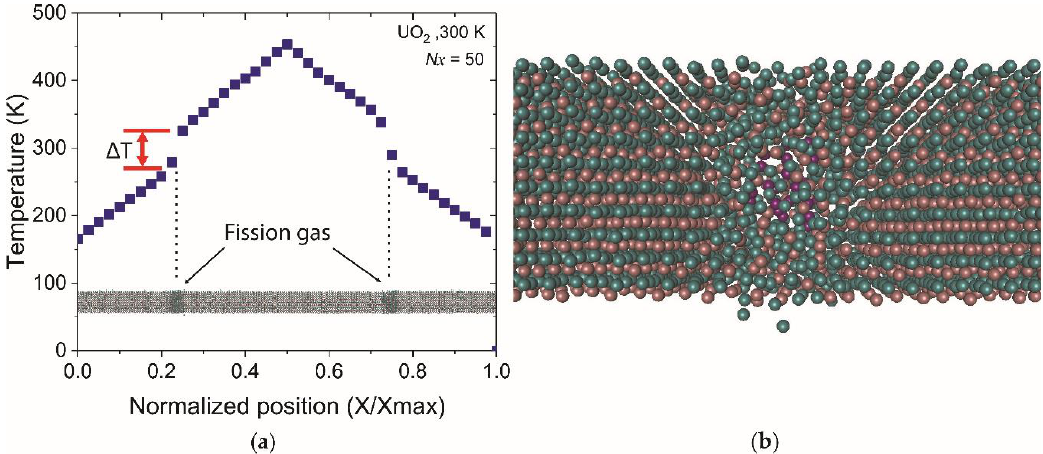
Figure 8. ( a ) Temperature profile during RNEMD for UO 2 with 15 Kr / 15 Xe fission gases. ( b ) Alteration of the lattice structure of UO 2 caused by the presence of fission gas bubble.